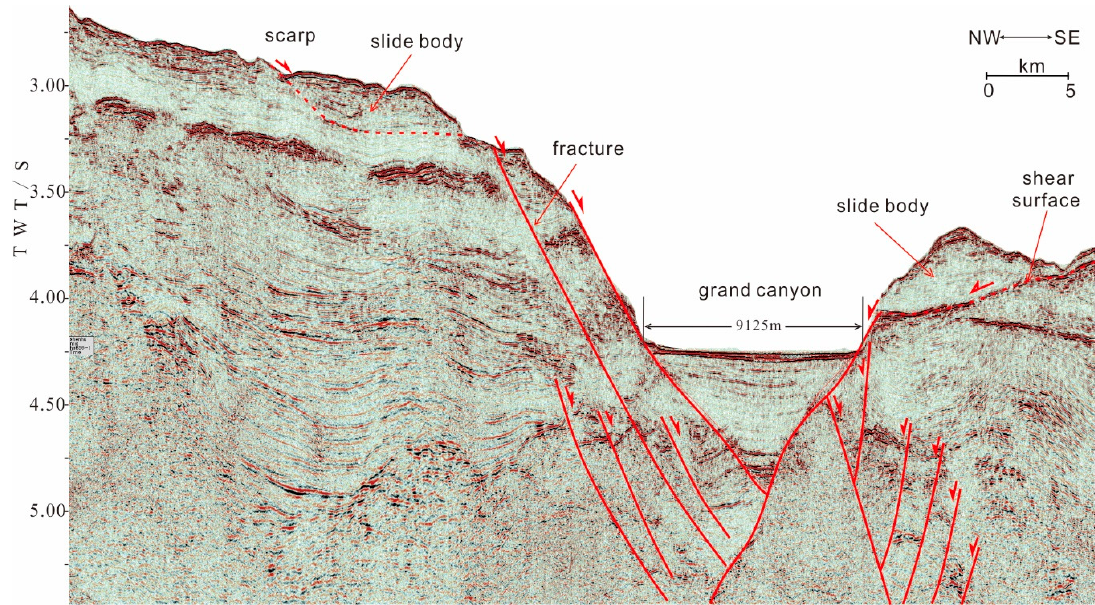
Figure 7. Seismic reflection of Line 6 is a landslide induced by erosion.